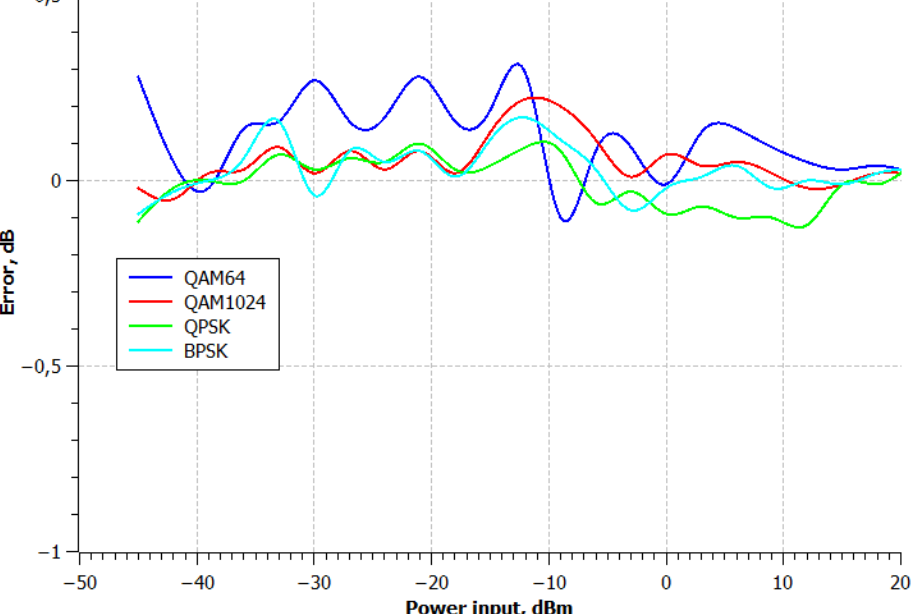
Fig. 8. The digital modulated signal measurements deviation error with NRPC and